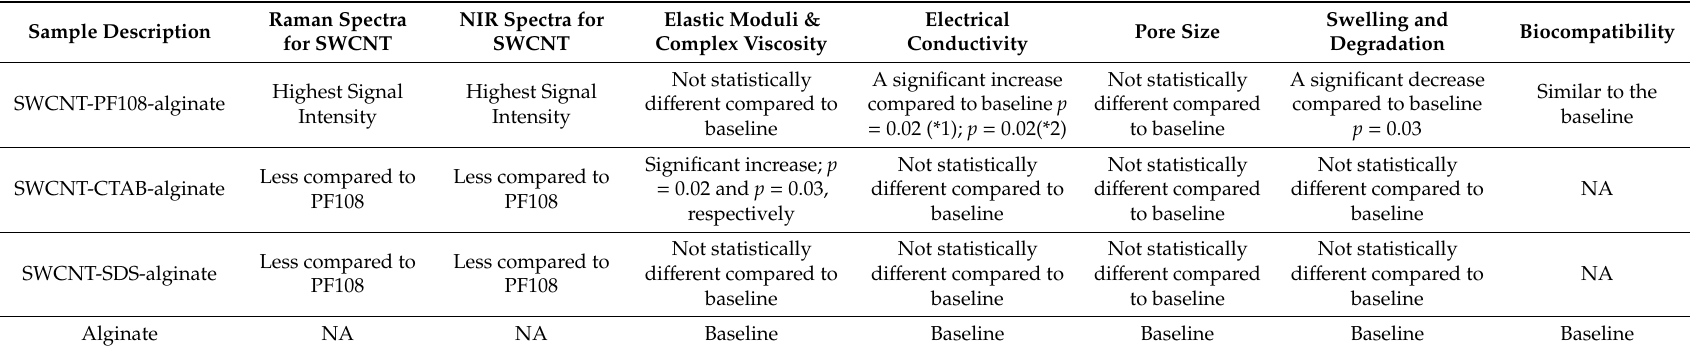
Table 1. Summary of results. p -values indicated were obtained from two-way ANOVA followed by Tukey post-test for multiple comparisons were performed to determine the statistical significance between individual sample groups, and comparison of all SWCNT-surfactant-alginate with alginate controls. Results from comparisons having statistical significance ( p < 0.05) were